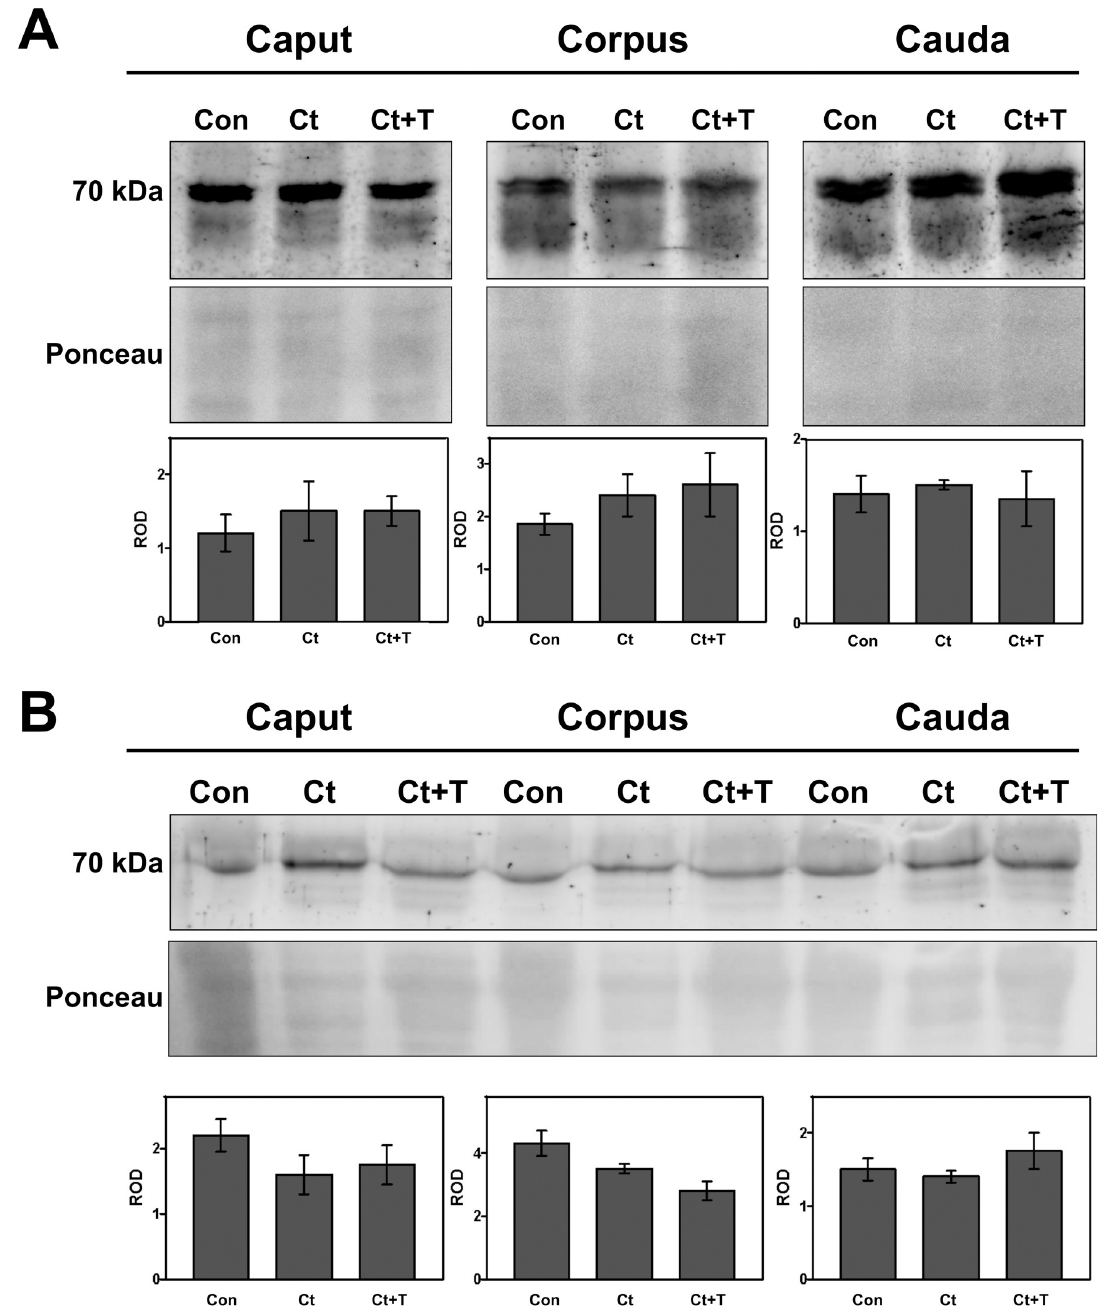
Fig 7. Immunodetection of prosaposin in whole epididymal tissue (A) and luminal fluid (B) of the epididymis from control (Con), castrated (Ct) and castrated with testosterone supplementation (Ct+T) animals. The figure shows a representative immunoblot of each region and experimental condition and the quantification of the bands in each case. Bars represent the means of relative optical density (ROD) ± SE from three independent experiments. No significant differences were noted between (C, Ct and Ct+T). Ponceau staining was used as loading